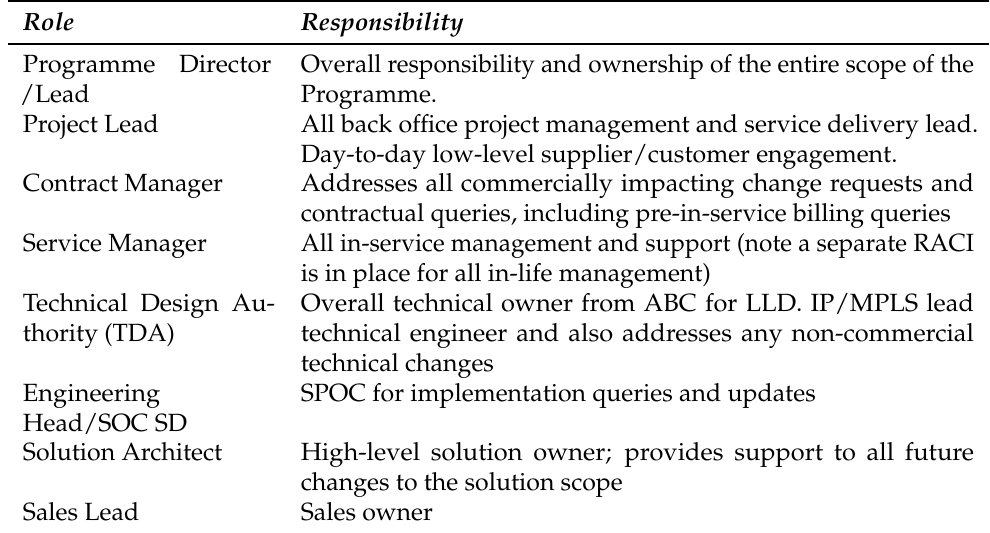
Table 9. Role and Responsibilities Table.